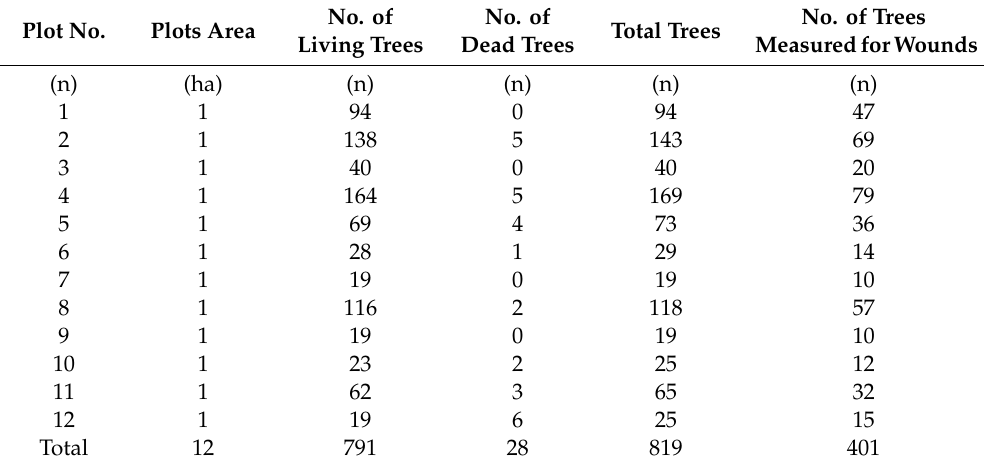
Table 3. The basic measurement data for 819 trees (from field